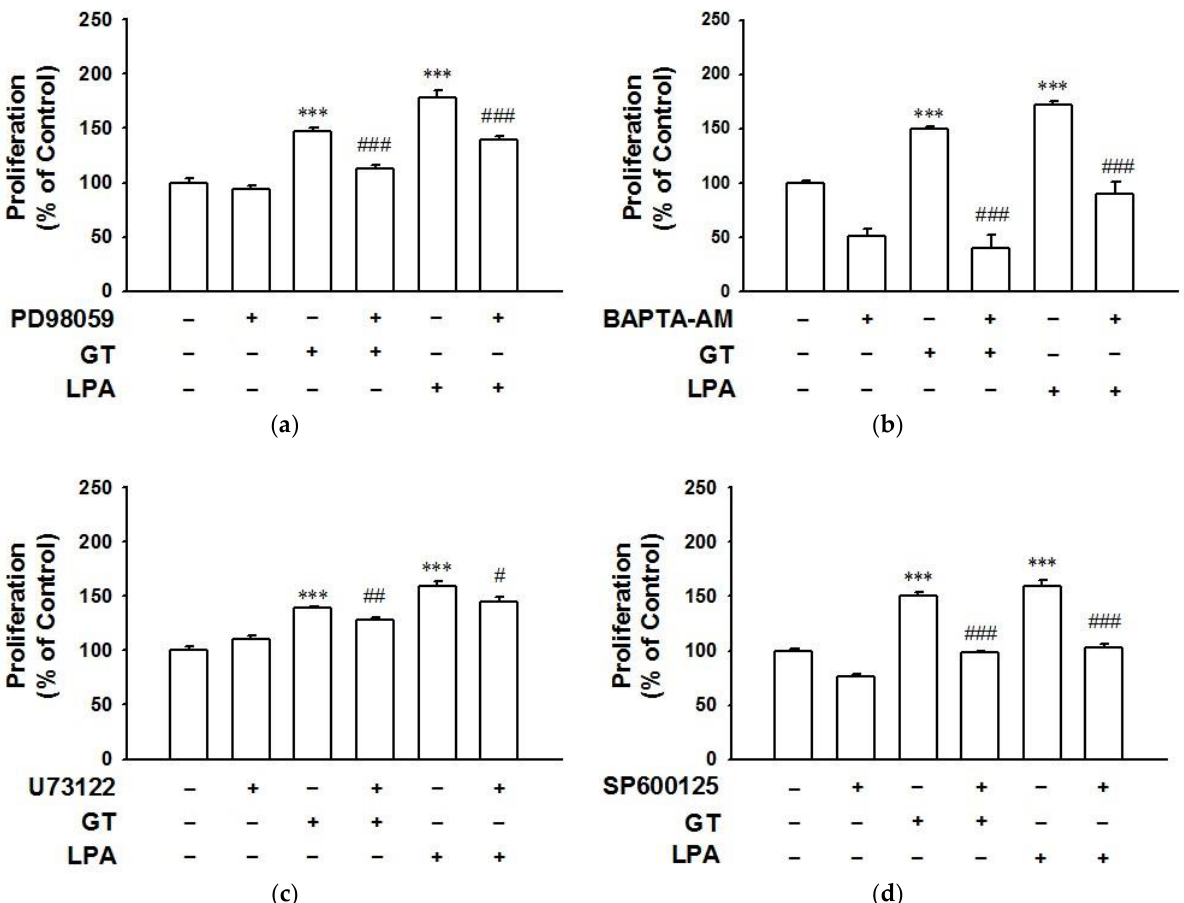
Figure 4. Effects of inhibitors on gintonin-induced proliferation of HaCaT cells. Cells were incubated in serum-free medium containing gintonin (GT, 10 µ g/mL) or lysophosphatidic acid (LPA, 10 µ M) in the presence or absence of inhibitors for 24 h. Then, the XTT-based assay was performed. Inhibitors used were: ERK inhibitor PD98059 (10 µ M) ( a ), calcium chelator BAPTA-AM (10 µ M) ( b ), PLC inhibitor U73122 (5 µ M) ( c ), and JNK inhibitor SP600125 (20 µ M) ( d ). LPA was used as a positive control. Response of untreated cells was considered as 100%. Data are presented as the means ± S.E.M. ( n = 6); *** p < 0.001 vs. untreated cells; # p < 0.05; ## p < 0.01; ### p < 0.001 vs. GT or LPA alone.